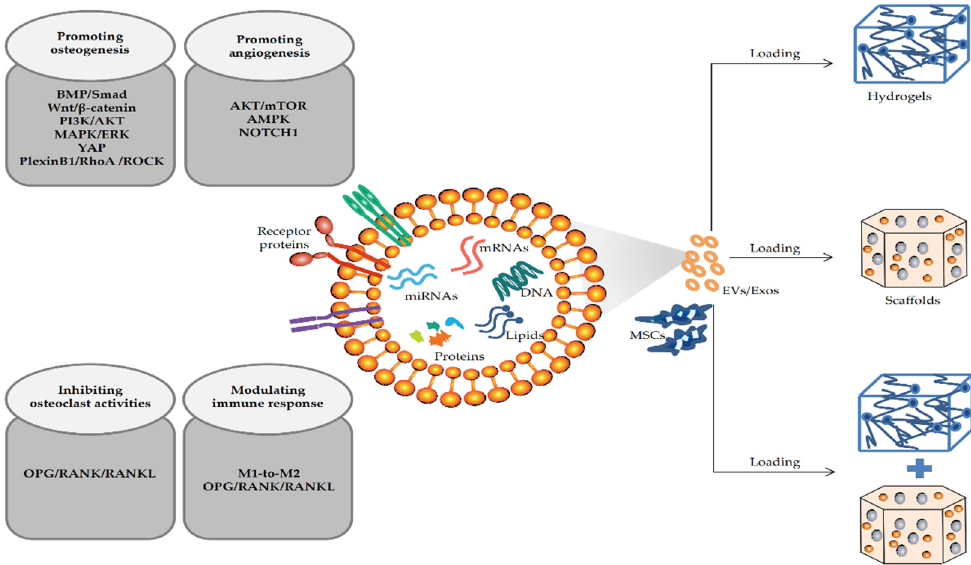
Figure 2. Mechanisms of MSC-EVs/MSC-Exos promoting the repair of bone defects in